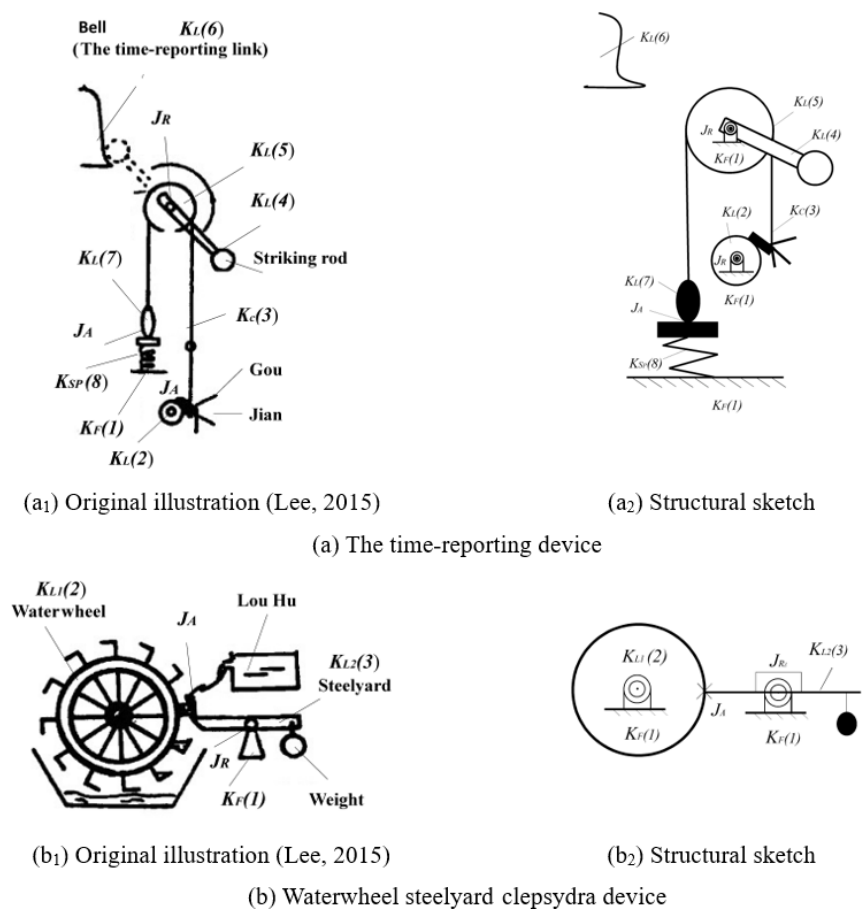
Figure 2. Reconstruction concepts of the water-powered celestial globe by Li Zhichao (Liu, 2015). (a) The time-reporting device’s original drawing and schematic diagram. (b) The waterwheel and the steelyard original drawing and schematic diagram.